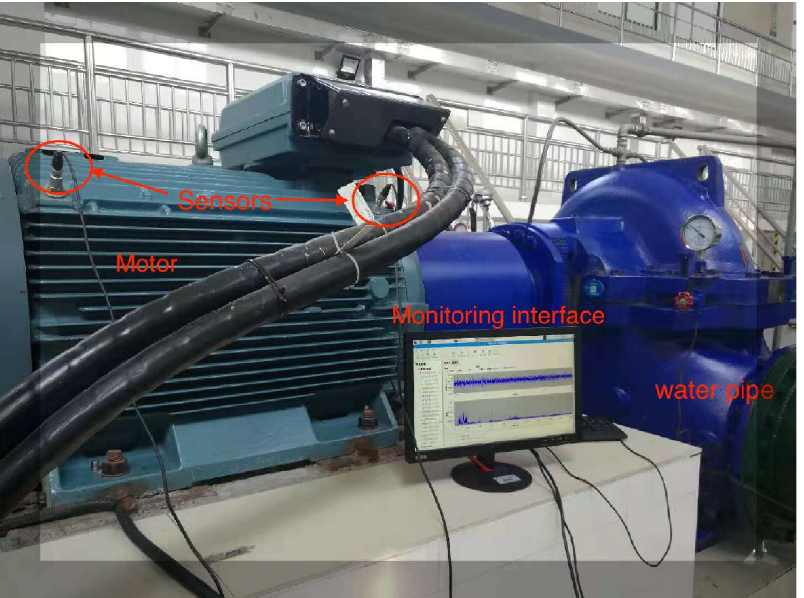
Figure 6. Water pump room of a water supply company with seven large-scale pumps, including gearboxes and water